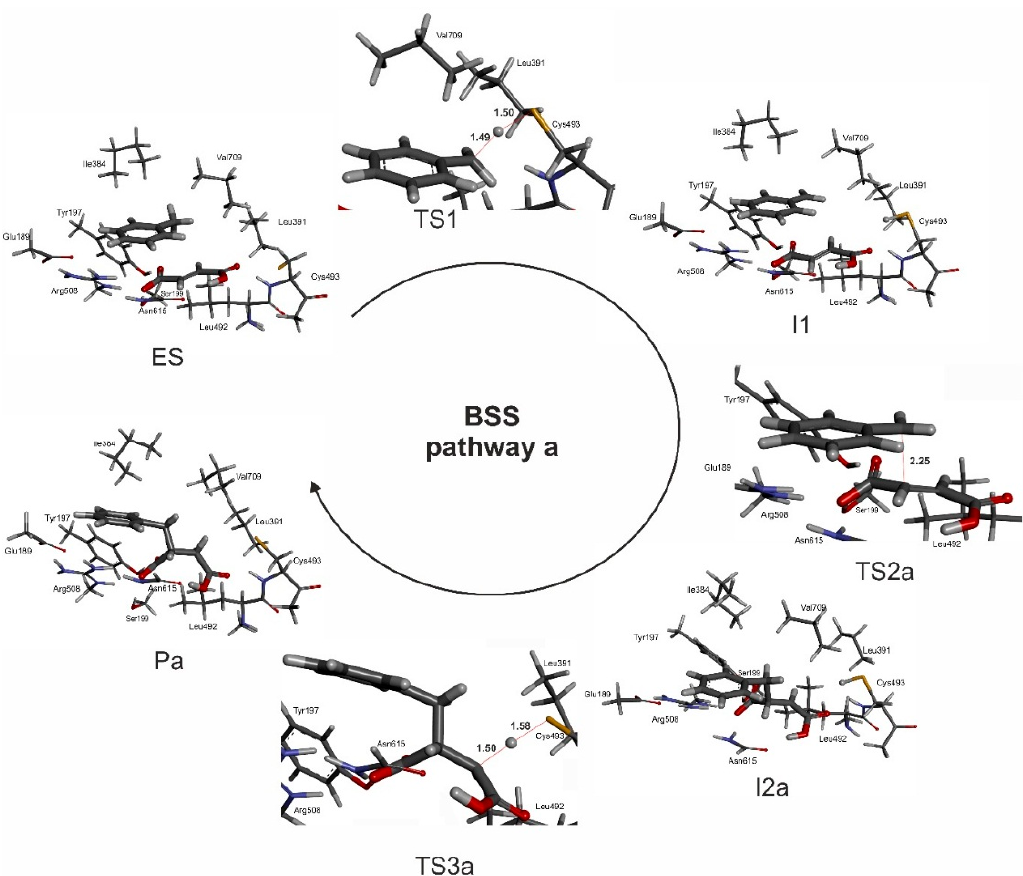
Figure 10. The reaction catalyzed by BSS (variant a ).